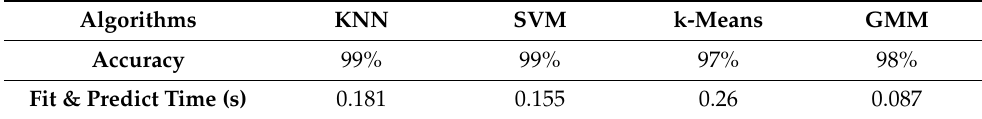
Table 3. Time evaluation of each algorithm.